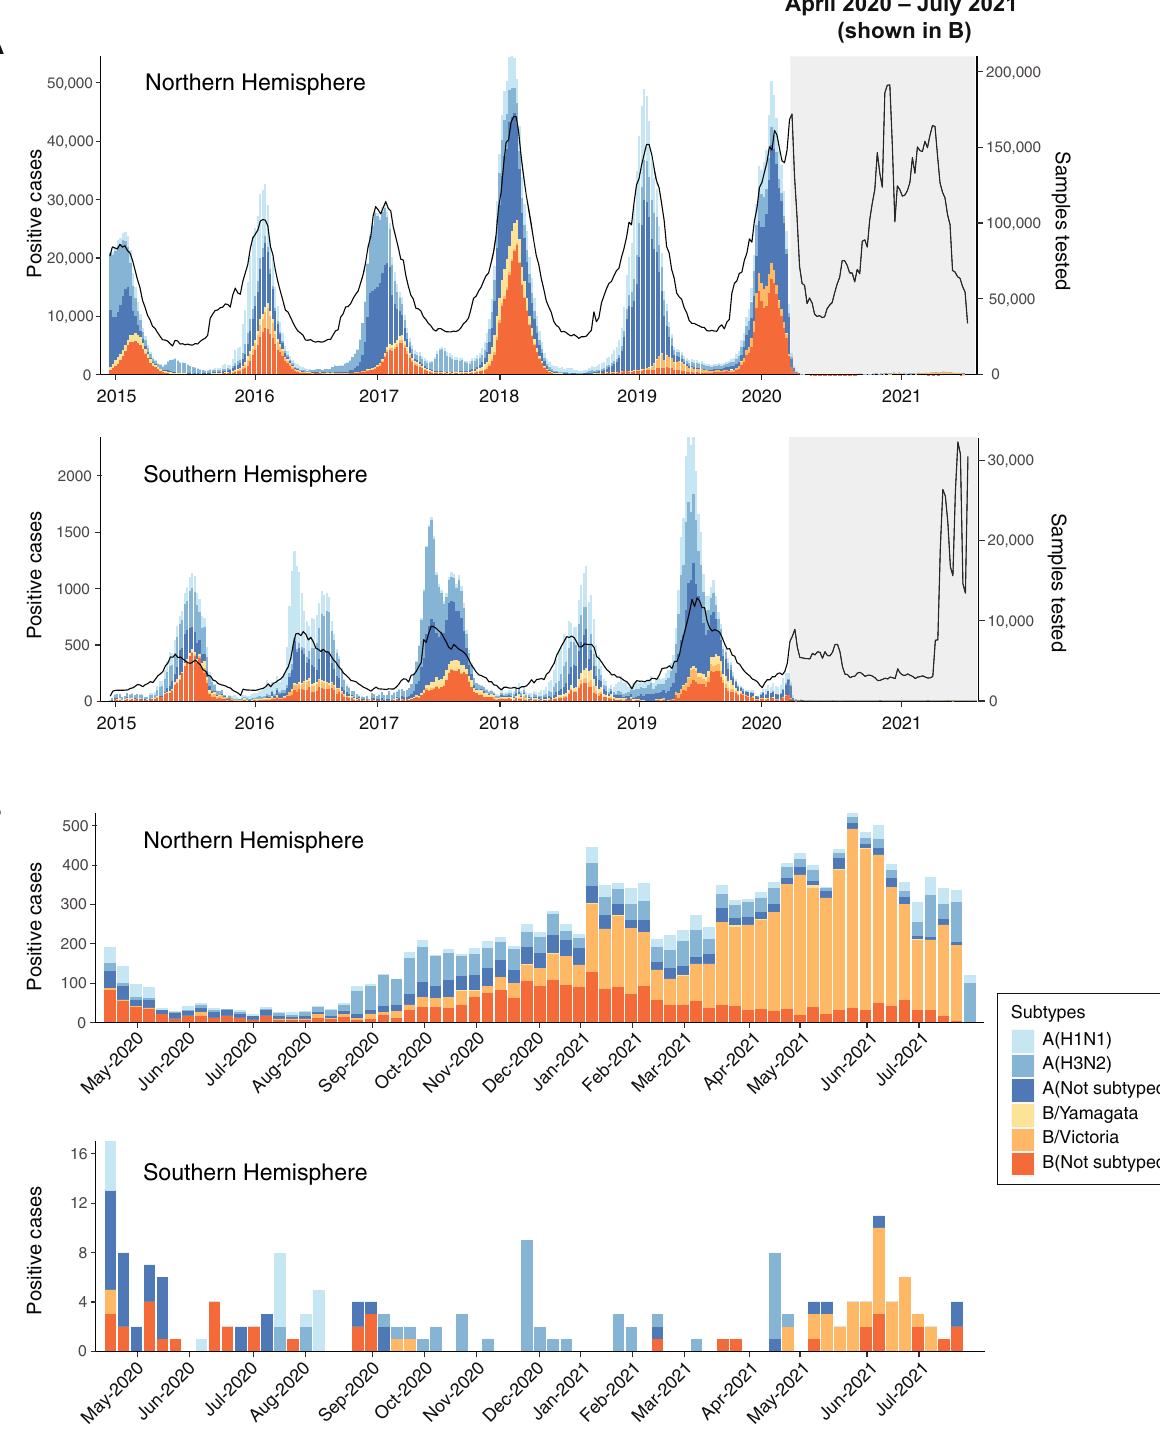
Fig. 2 Virological surveillance of seasonal in fl uenza viruses. A Time series comparing FluNet data on seasonal in fl uenza activity in the Northern and Southern Hemispheres from 2015 to July 2021, with the COVID-19 pandemic shaded in gray. Stacked bar chart (left-hand y -axis) represents the number of in fl uenza-positive cases per week colored by subtype. Black trend-line (right-hand y -axis) shows the number of specimens tested per week. B Magni fi ed view of the gray-shaded bar charts in A showing in fl uenza-positive specimens from April 2020 to July 2021. Note: y -axis scales differ in each